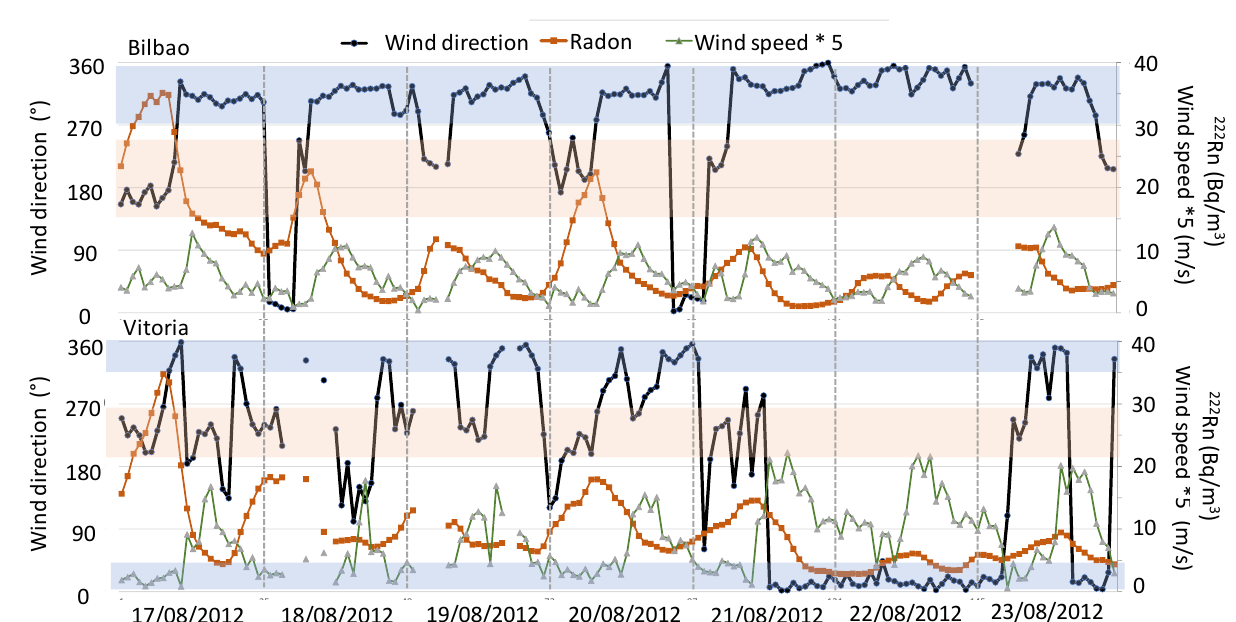
Figure 9. Daily variation in wind direction and speed, and 222 Rn activity concentration between 17th and 23rd August 2012 at Bilbao and Vitoria. Note differences in scales. Blue area represents wind direction of maritime flow, while brown area represents continental